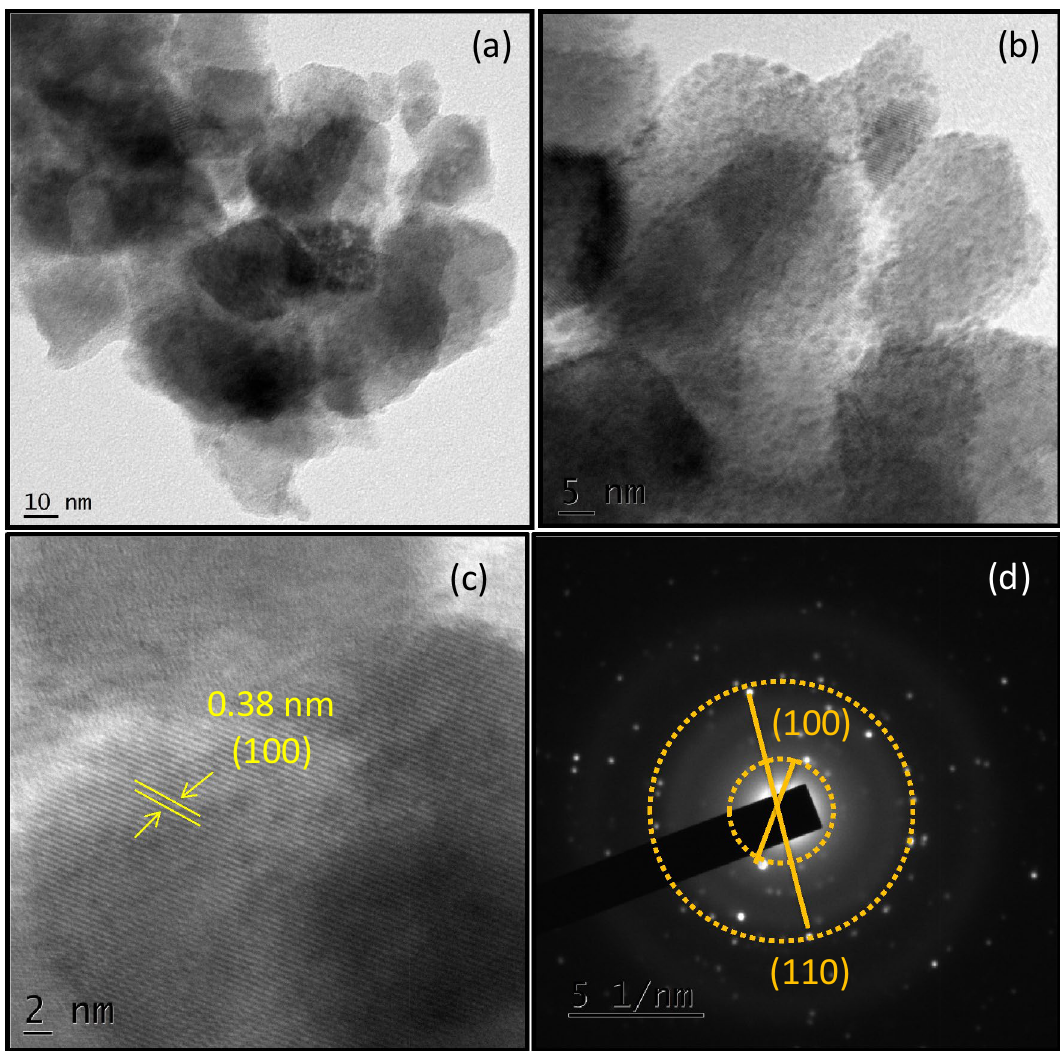
Figure 4. ( a , b ) TEM images with different magnifications ( c ) d-spacing value well matched with 100 XRD plane ( d ) SAED pattern showing 2 bright fringes of 3D-F-KT NPs (0.4 g concentration of areca seed powder